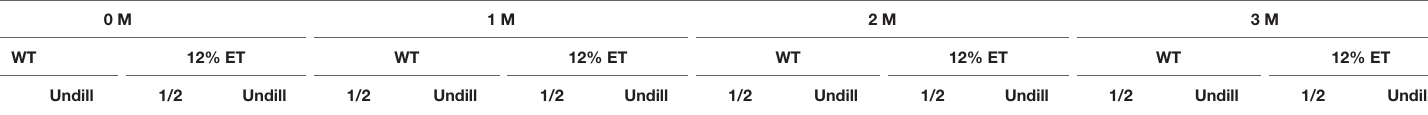
TABLE 3 | α -Amylase enzyme inhibitory activity of aqueous (WT) and ethanol (12%ET) extracts of Cortland apple peel (A) ( ½ and undiluted) and pulp (B) (1/5th and ½ diluted) with elicitor treatments (DPA, OX, and COS) during 3 months of storage.